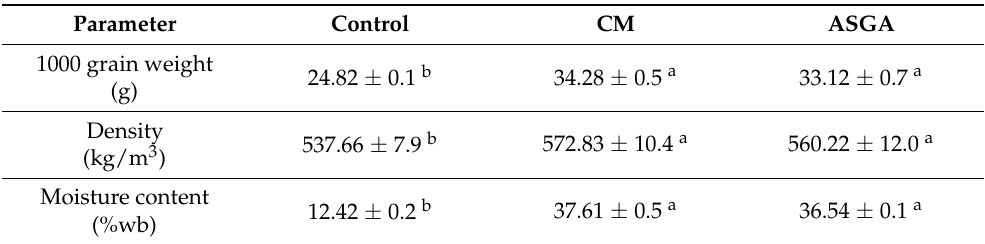
Table 1. Comparison of hydration and physical characteristics of non-soaked ‘Khao Dawk Mali 105’ in raw rough rice (control) and soaking using the conventional method (CM) and an automatic soaking and germination accelerator unit